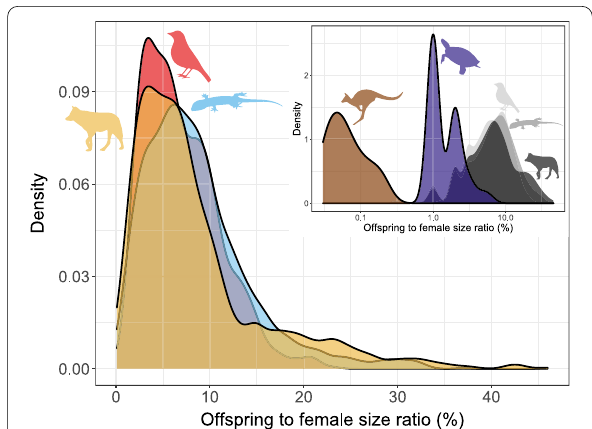
Fig. 4 Offspring size (expressed as % of offspring size to the size of adult females). Red: birds; blue: squamates; purple: turtles; yellow: placental mammals; brown: marsupial mammals. Note that the x axis is log 10 scaled in the inset figure. Size ratio close to zero (< 0.03) only occur in marsupials (inset; values < 0.03 not shown)